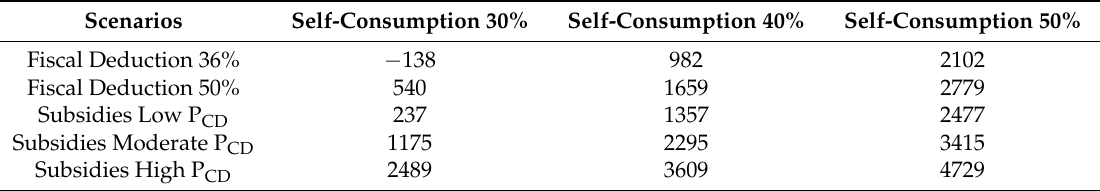
Table 5. NPV in alternative scenario (p c = 21 cent € /kWh). Data expressed in €